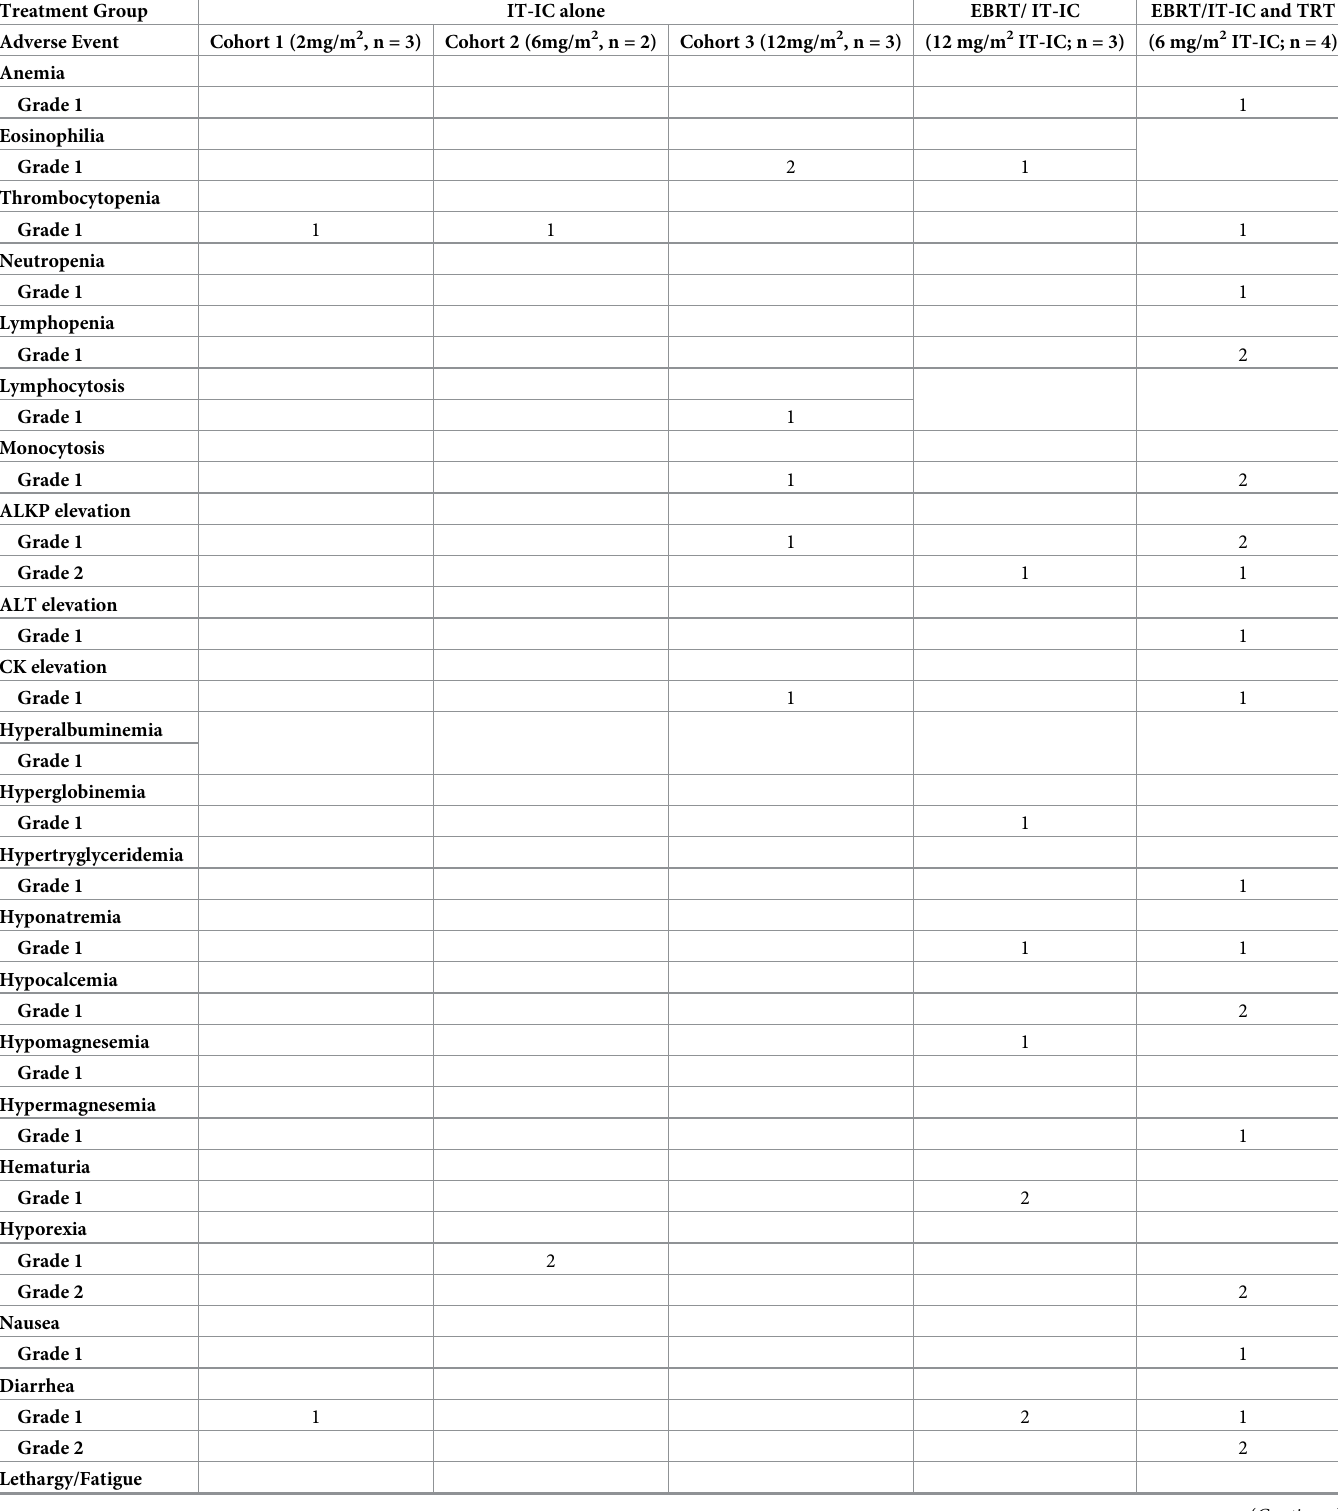
Table 1. Adverse event summary for all dogs by treatment